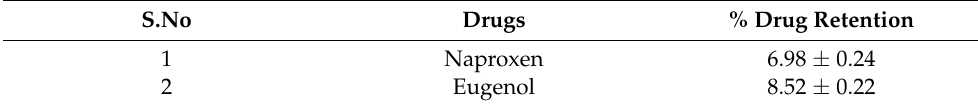
Table 8. Skin retention of naproxen and eugenol from optimized emulgel.